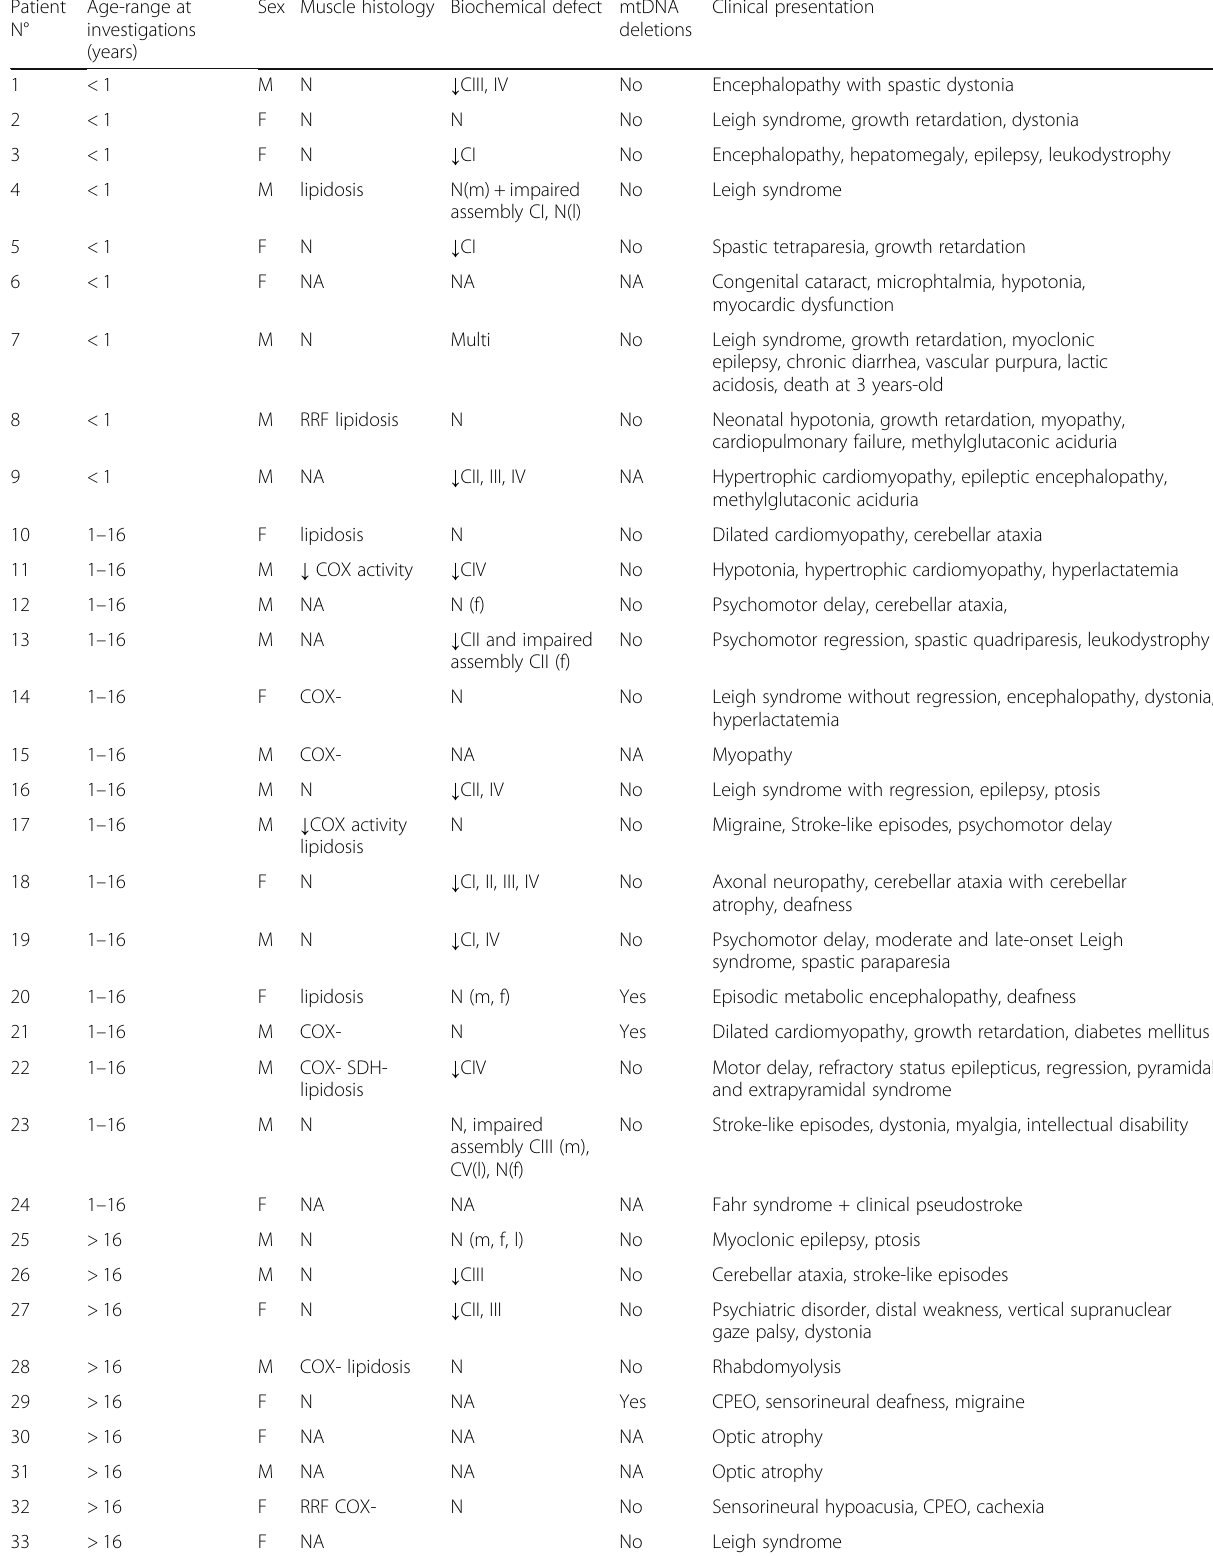
Table 1 List of the patient cohort Patient